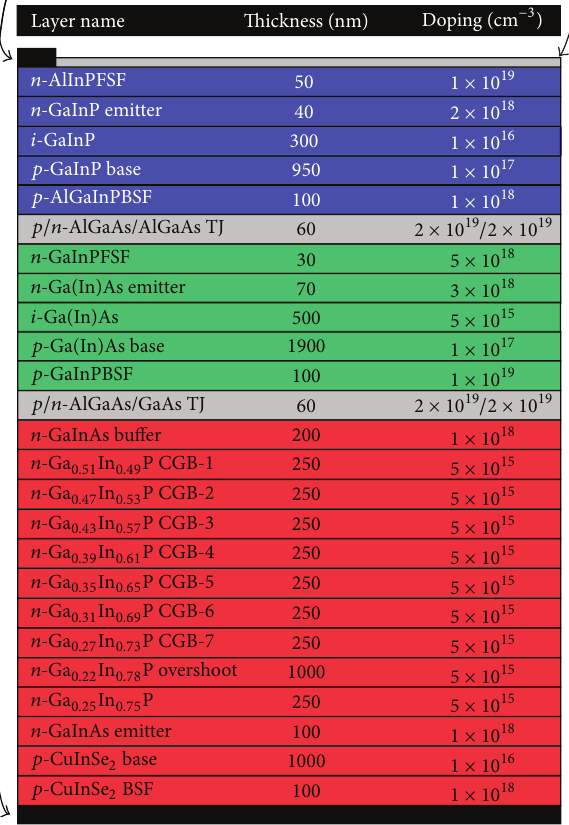
Figure 2: Structural details of the inverted metamorphic GaInP/Ga(In)As/CuInSe 2